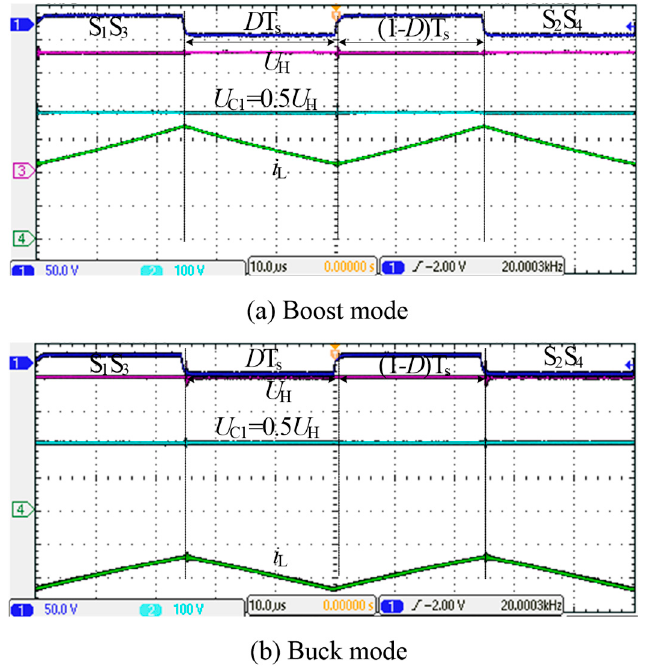
Figure 5. Experimental verification of the switch capacitor TL-BDC.